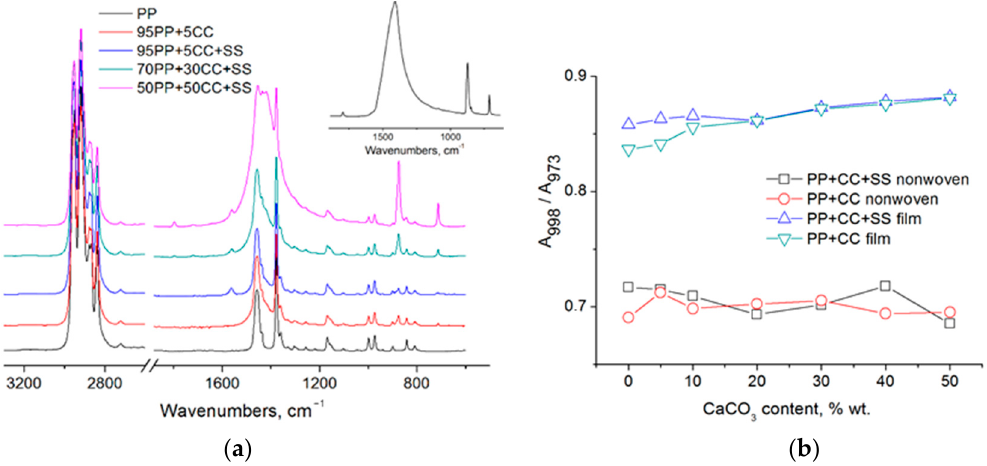
Figure 6. FTIR spectra of the produced nonwoven materials ( a ); effect of CaCO 3 content on the A 998 / A 973 ratio ( b ). Inset—spectra of pure calcium carbonate.